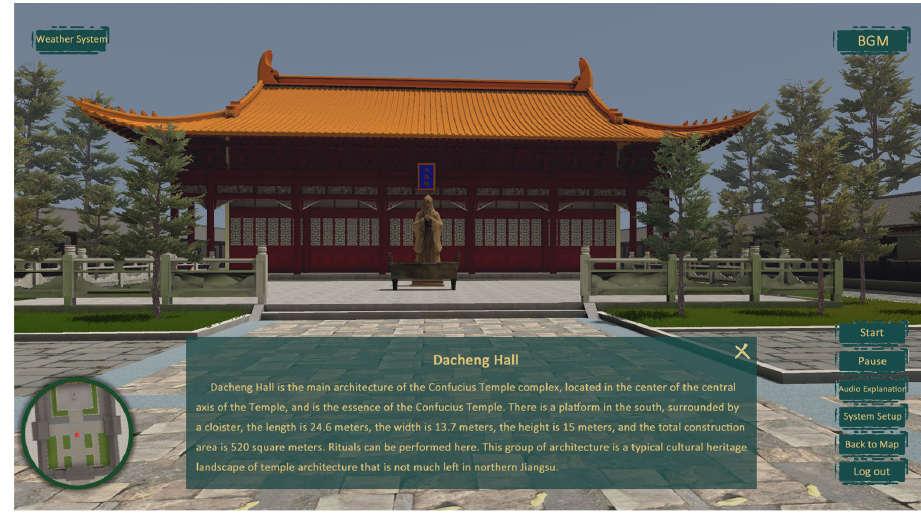
Figure 9. Roaming interface of religious scene reproduction system based on a microcosmic scale.